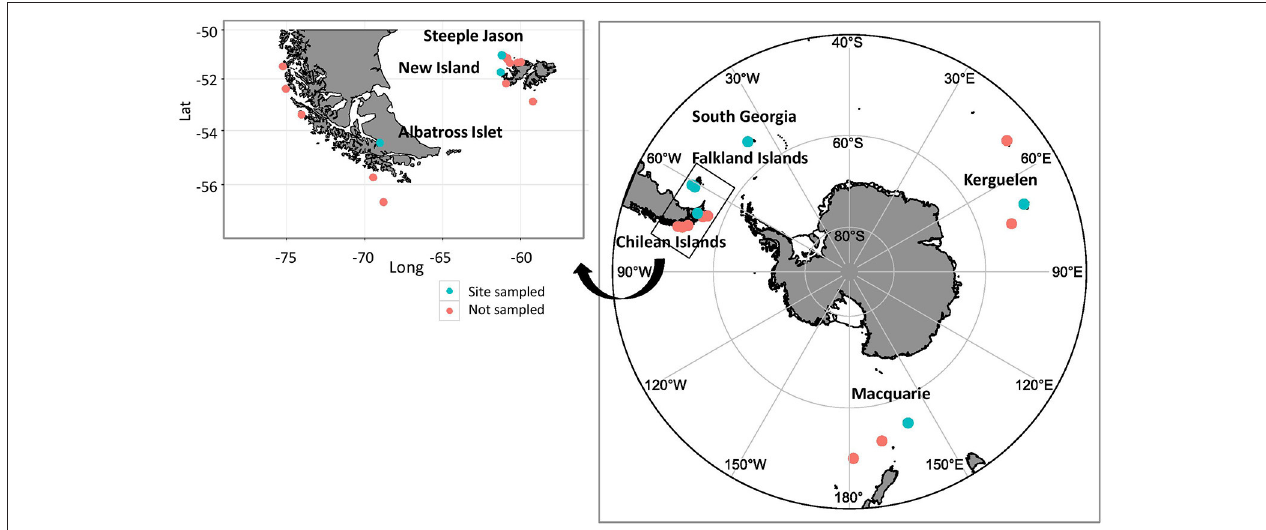
FIGURE 1 | Breeding distribution of black-browed albatrosses and sampling sites. Blue dots represent the six colonies where scat samples were collected, and the red dots the remaining colonies not sampled during the study. The inset shows the individual Chilean and Falkland Island colonies. Samples were collected from Albatross Islet, Chile (40–50 breeding pairs, population increasing); New Island (13,343 breeding pairs, population increasing) and Steeple Jason Island (183,135 pairs, population increasing), Falkland Islands; Bird Island, South Georgia (8,264 breeding pairs, population declining); Canyon des Sourcils Noirs, Iles Kerguelen ( ∼ 1,200 breeding pairs, population stable); and Macquarie Island ( ∼ 200 breeding pairs, population stable; ACAP, 2010; Wolfaardt, 2013; Robertson et al., 2014; Phillips et al., 2016; Poncet et al., 2017)